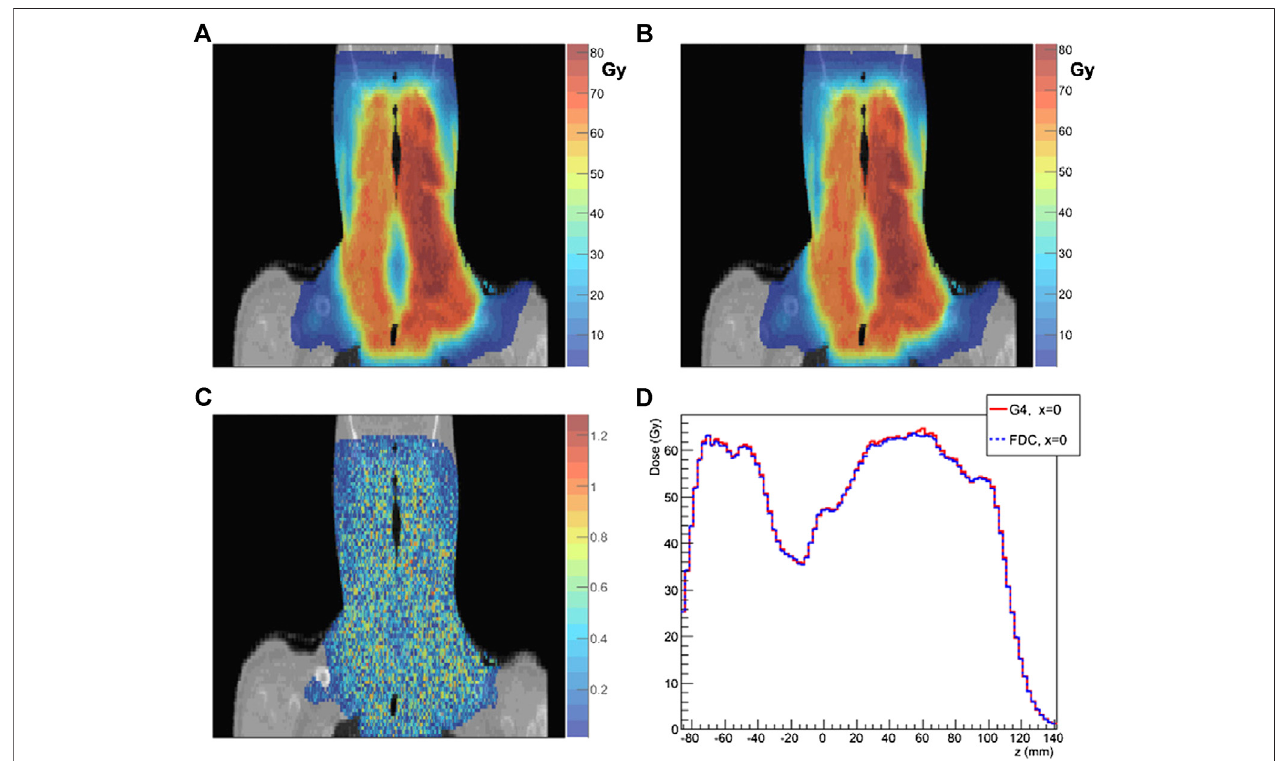
FIGURE 12 | Comparison of results from the FDC developed by Yepes et al. [241] and GEANT4. Dose distribution for a particular coronal section of a head-and- neckpatient:as (A) GEANT4and (B) FDC. (C) 2 mm/2%gamma-indexforthevoxelsonthatparticularsectionofFDCrelativetoGEANT4. (D) Forthesamesection,the dose along the z -axis (inferior-superior) for x (cid:3) 0 calculated with GEANT4 and FDC for that